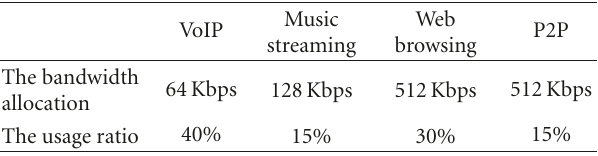
Table 1: The bandwidth allocation and the service usage ratio per service type.